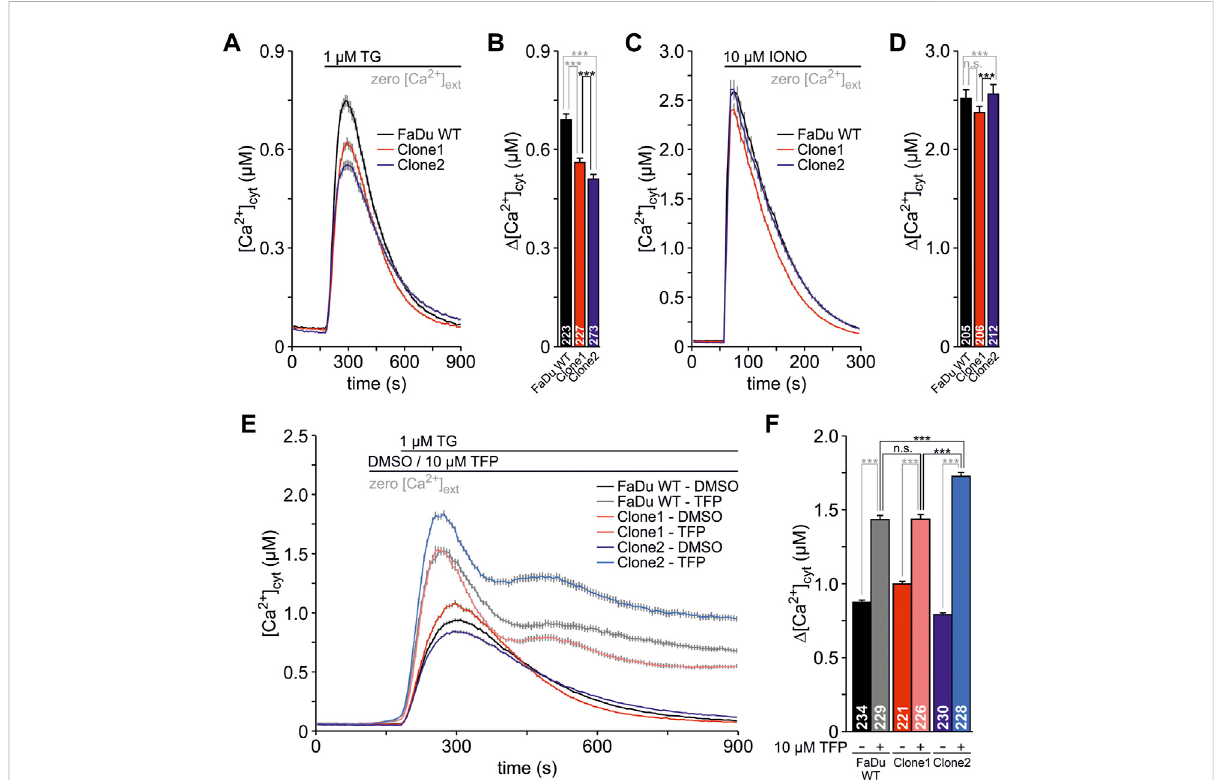
FIGURE 6 Live cell Ca 2+ imaging of FaDu wt and SEC62 -knockout clones. The responses of the cells to TG and IONO were visualized by detecting the cytosolic Ca 2+ concentration ([Ca 2+ ] cyt ) with FURA-2. The cells were seeded onto poly-L-lysin coated coverslips 24 h prior to the live cell Ca 2+ imaging experiments. (A) The Ca 2+ leak from the ER was unmasked using 1 μ M TG in absence of extracellular Ca 2+ (zero [Ca 2+ ] cyt ) (B) The TG responses were analysed by the increase from the basal to the maximal [Ca 2+ ] cyt and are illustrated as Δ [Ca 2+ ] cyt (C) The Ca 2+ mobilisation from internal stores was induced by the application of 10 µM IONO in the presence of zero [Ca 2+ ] cyt to evaluate the total Ca 2+ content of the cells (D) The IONO responses were expressed as Δ [Ca 2+ ] cyt (E) During the measurements, cells were treated with 0.1% DMSO (as a control) or 10 µM tri fl uoperazine(TFP)for1 minute.Subsequently,1 μ M TGwasusedtounmasktheCa 2+ leakfromtheER (F) Theresponsesofthedifferenttreatments are shown by Δ [Ca 2+ ] cyt . Data is shown as mean ± SEM. The total number of analysed cells from three independent experiments is indicated within graph bars for each cell line. n.s., not signi fi cant; ***, p <